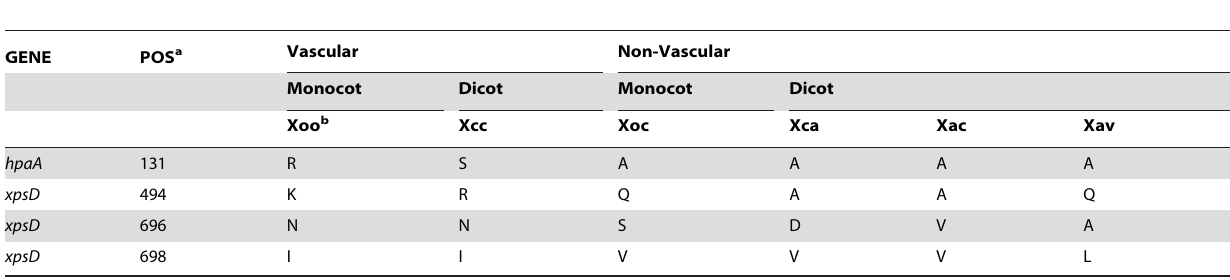
Table 2 . Amino acid residues in alignments of pathogenesis-associated gene products that correlate with tissue-specificity across eight Xanthomonas